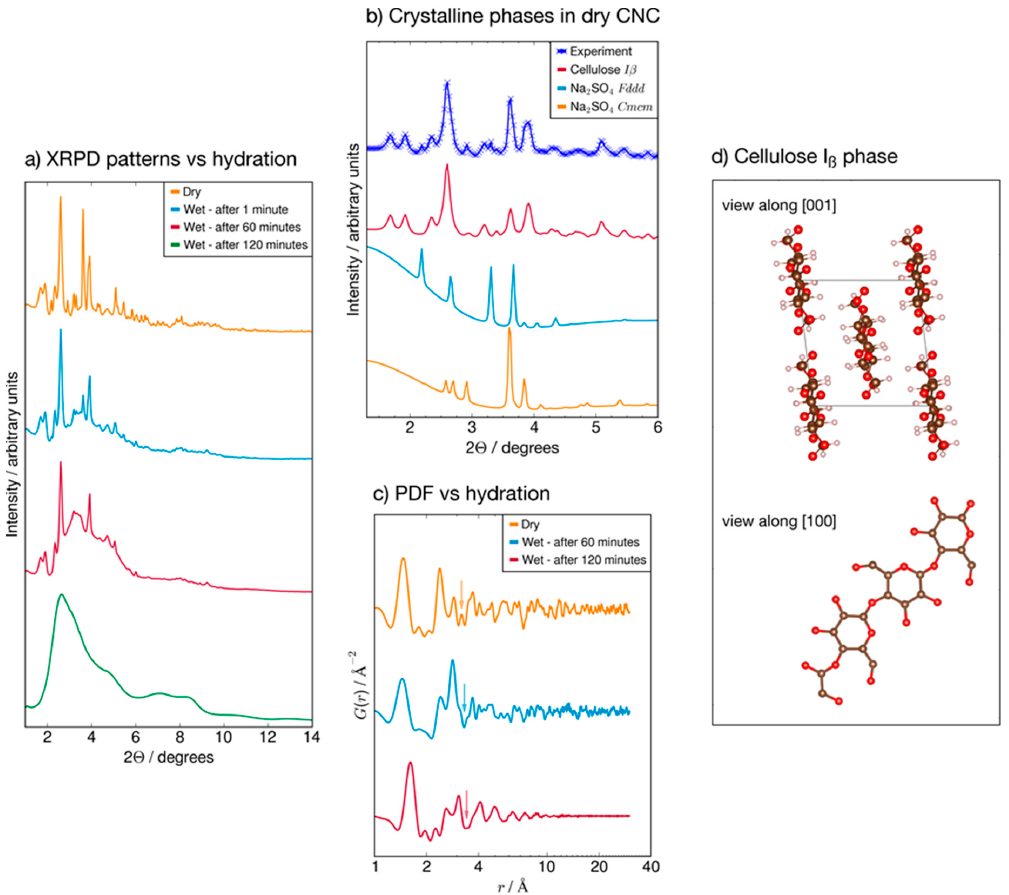
Figure 8. Raw XRPD (X-ray Powder Diffraction) patterns of CNCs in the dry state and after successive exposures to 100% RH ( a ), breakdown of the XRPD pattern of the dry CNCs sample into the constituent crystalline phases ( b ), the PDF curves of the dry sample and of the wet sample at the second and third hydration ( c ) and a view of the crystal structure of CNC along the crystallographic directions { 001 } and { 100 } ( d ).